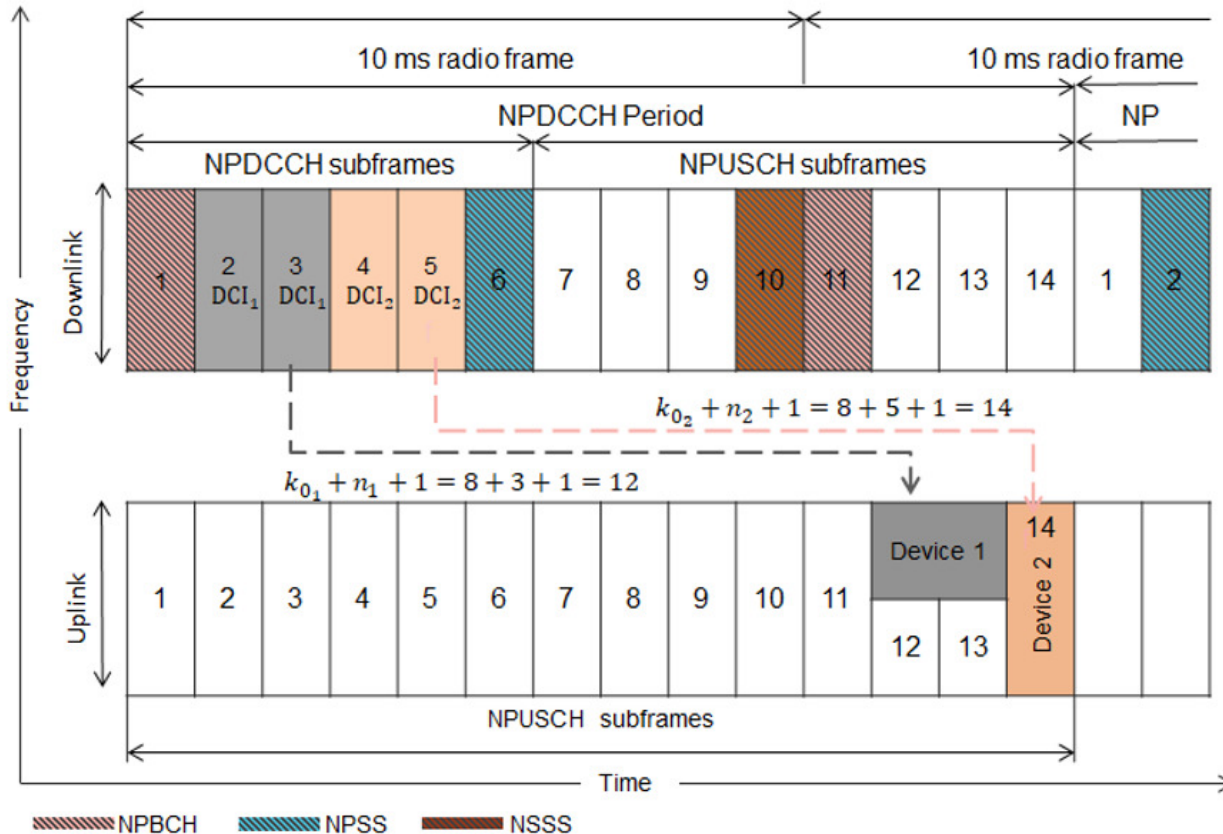
Figure 2. Scheduling Illustration